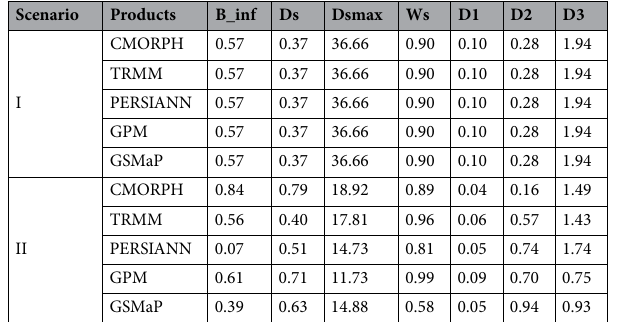
Table 2. Parameter calibration results in runoff simulation for VIC model under two scenarios.